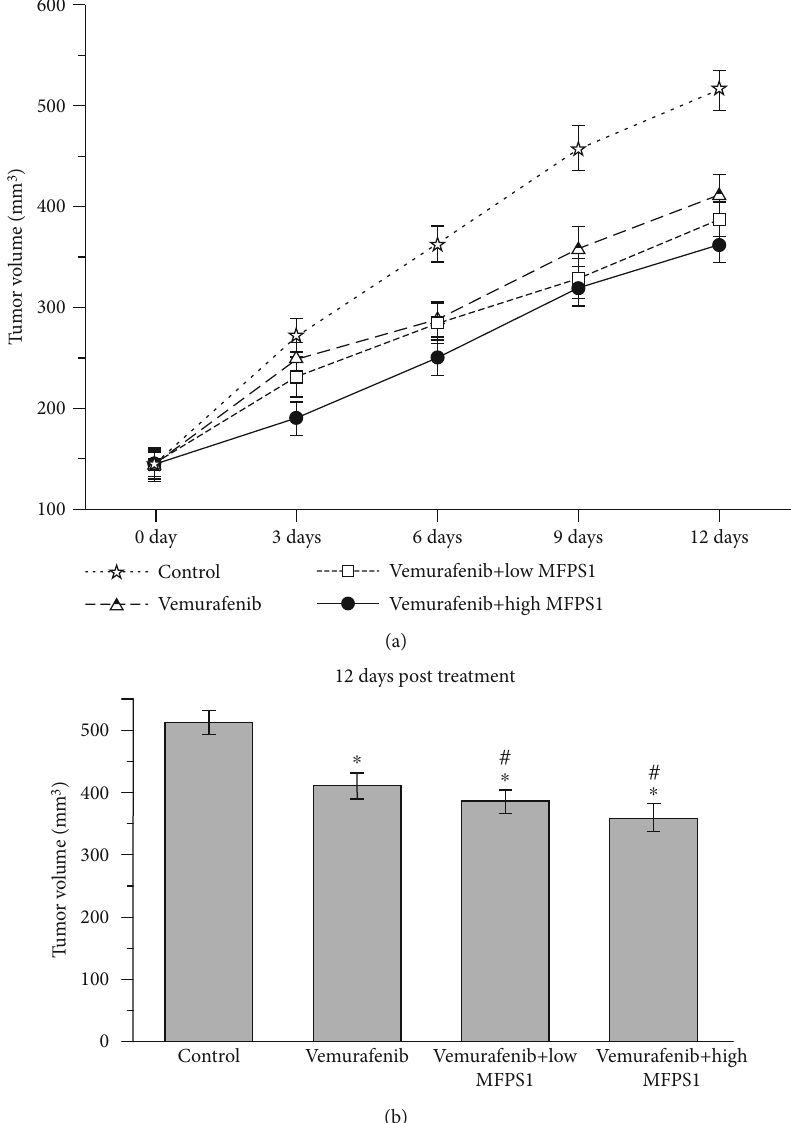
Figure 2: MFPS1 enhanced the inhibitory e ff ect of Vemurafenib on tumor growth in melanoma-bearing mice: (a) tumor growth curve of human melanoma MeWo cell-bearing mice 12 days after drug treatment; (b) tumor size of human melanoma MeWo cell-bearing mice at 12 days of drug treatment. ∗ represents the normal group as the control: ∗ p < 0 : 05 and ∗∗ p < 0 : 01 ; # represents the Vemurafenib group as the control: # p < 0 : 05 and ## p < 0 : 01